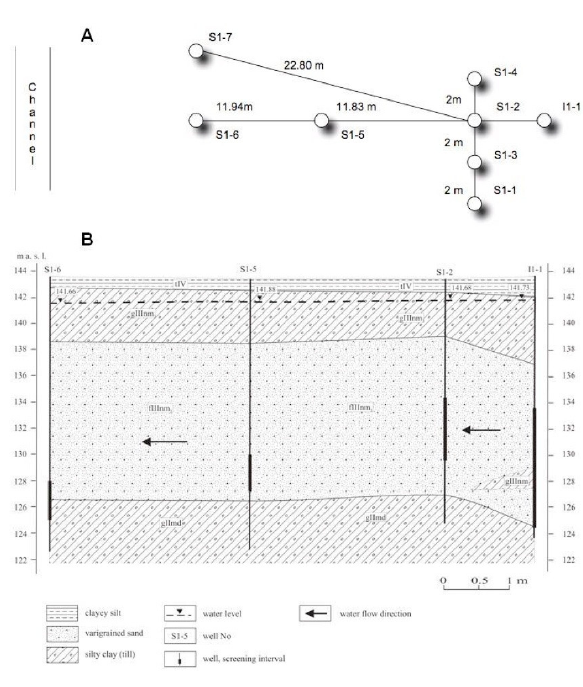
Figure 2: Scheme (A) and geological cross-section (B) of the first well system.